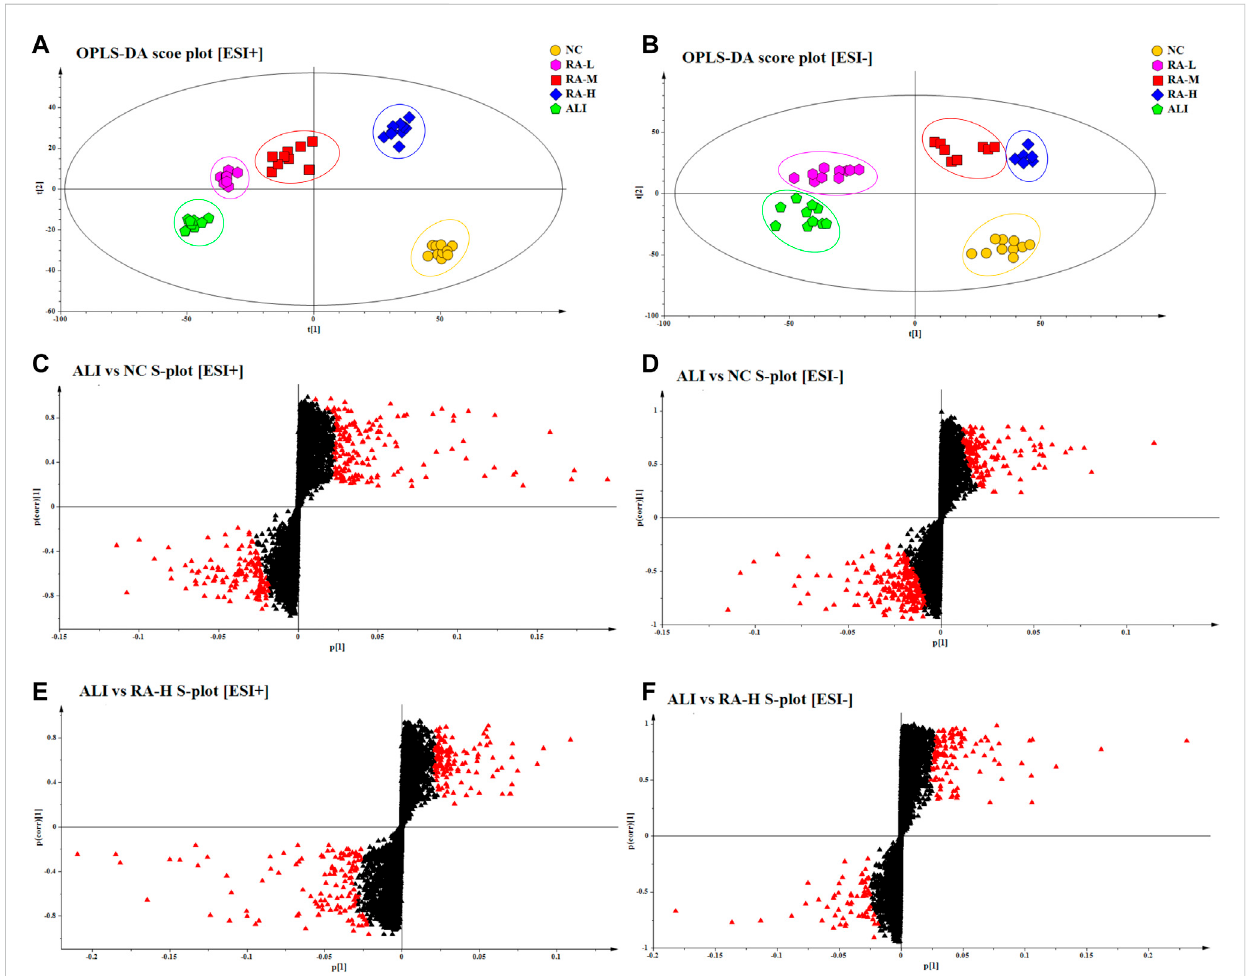
OPLS-DA score plots of different groups in ESI+ and ESI- mode respectively. The score plots of OPLS-DA of NC, ALI, RA-L, RA-M and RA-H from OPLS-DA analysis in ESI+ (A) and ESI- (B) ; Metabolites with VIP > 1 of ALI vs. NC were marked with a red triangle in ESI+ (C) and ESI- (D) ; Metabolites with VIP > 1 of ALI vs. RA-H were marked with a red triangle in ESI+ (E) and ESI- (F)